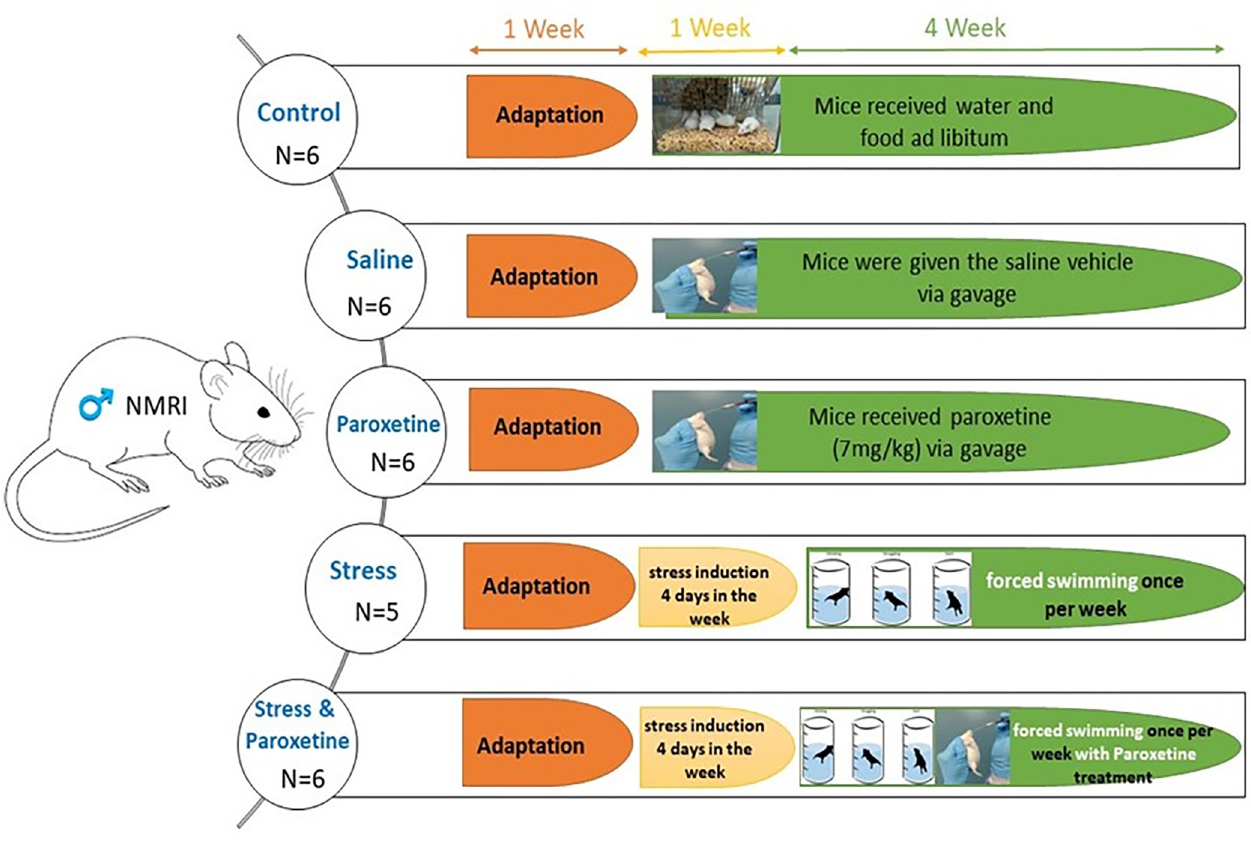
Fig 1. Flowchart of study design in animal